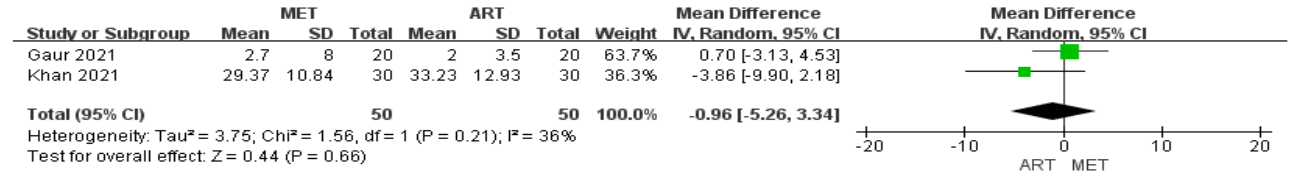
Figure 4. Meta-analysis of active knee extension (AKE) outcomes compared between muscle en- ergy technique (MET) and active release technique (ART) groups [41,43]. SD: standard deviation; CI: confidence interval.